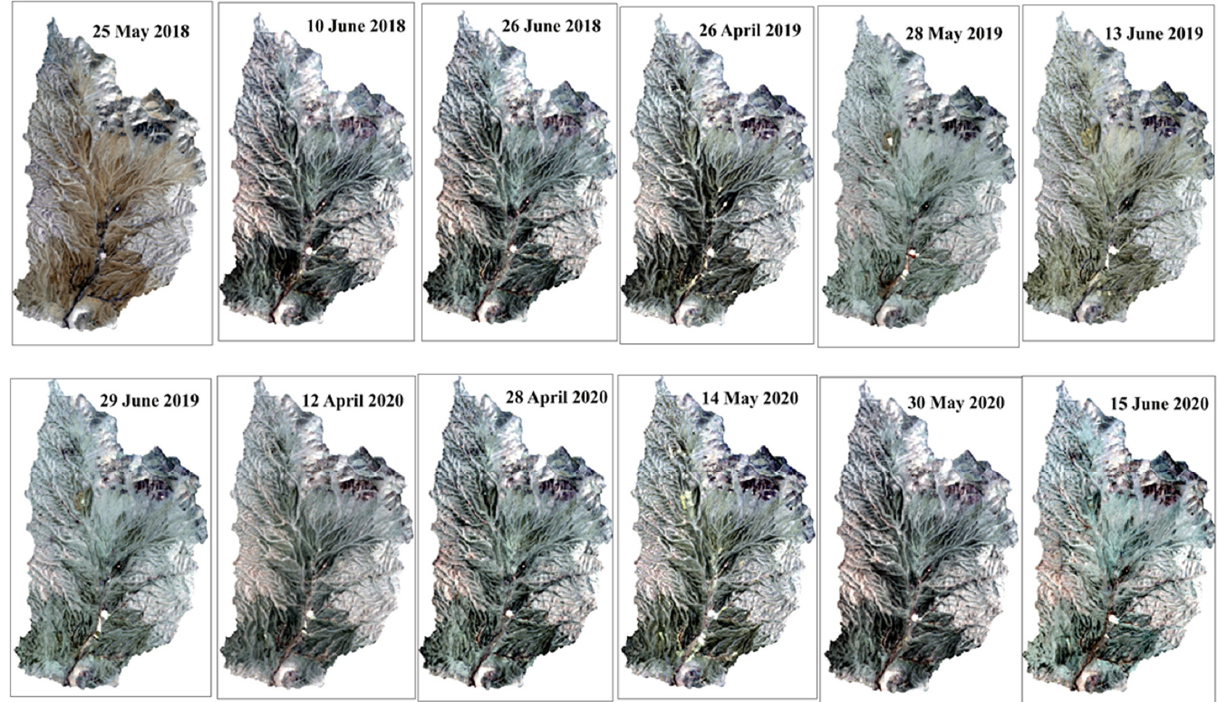
Remote Sens. 2021 , 13 , x FOR PEER REVIEW 12 of 17 Figure 7. A collection of RGB images from the optimal multi-temporal images for VT classification.